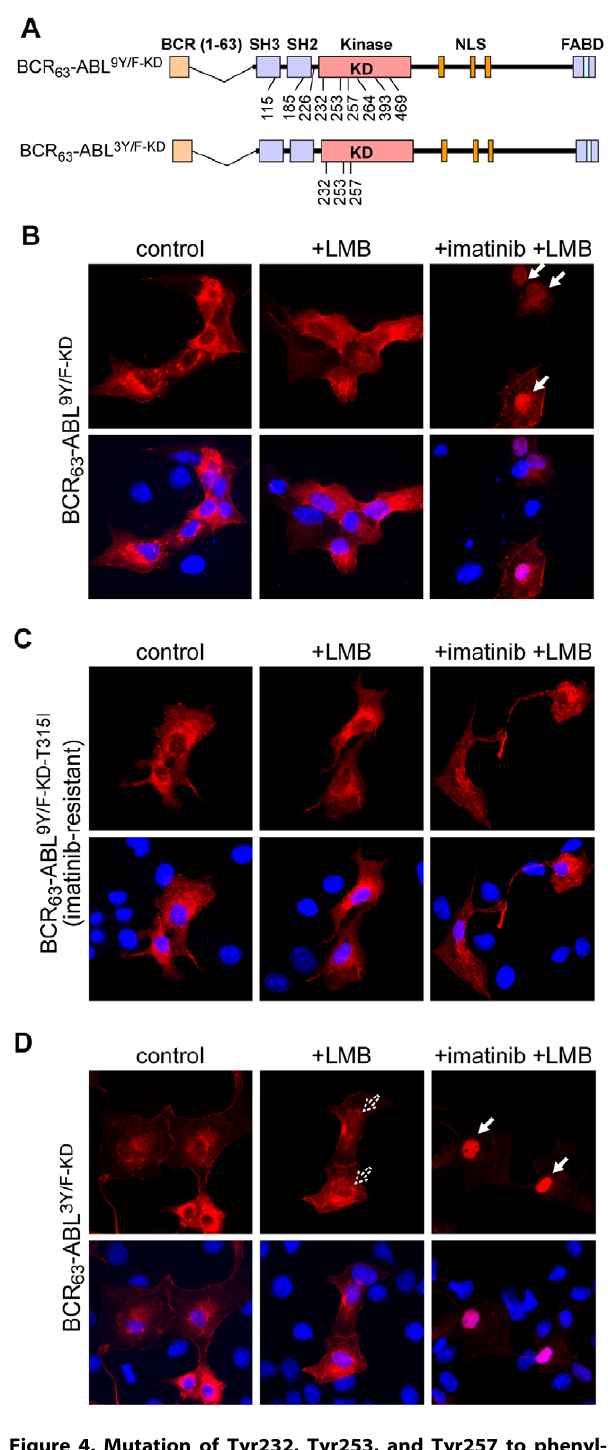
Figure 4. Mutation of Tyr232, Tyr253, and Tyr257 to phenyl- alanine blocks nuclear import of kinase-defective BCR 63 -ABL. A : Schematic representation of BCR 63 -ABL 9Y/F-KD and BCR 63 -ABL 3Y/F-KD constructs. The constructs encode catalytically inactive proteins due to the KD mutation (Lys271His) in the kinase domain. The position and amino acid number of the 9Y/F and the 3Y/F substitutions are indicated in the scheme according to the ABL-1a amino acid numbering. B : The kinase-defective BCR 63 -ABL 9Y/F-KD construct was transfected into COS cells and the localization of the protein determined by immunofluo- rescence. Nuclear localization of the kinase-defective protein was only observed in cells treated with 10 m M imatinib and 10 nM LMB,